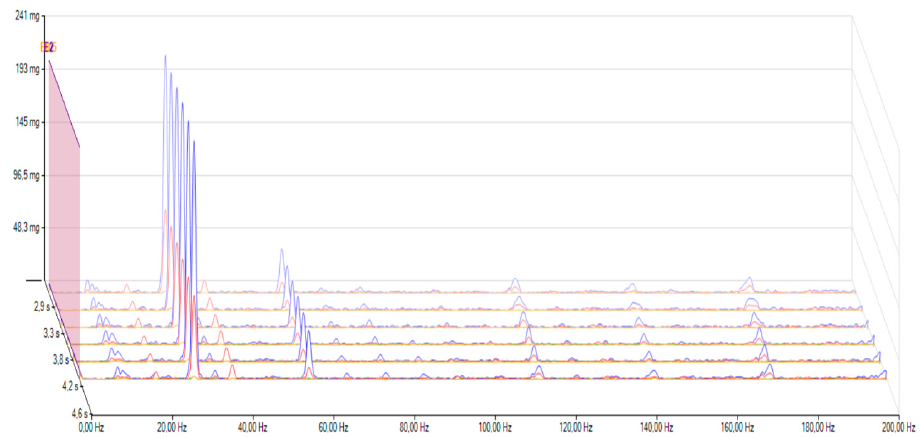
Figure 8. Vibrations in the frequency domain after the oil change.